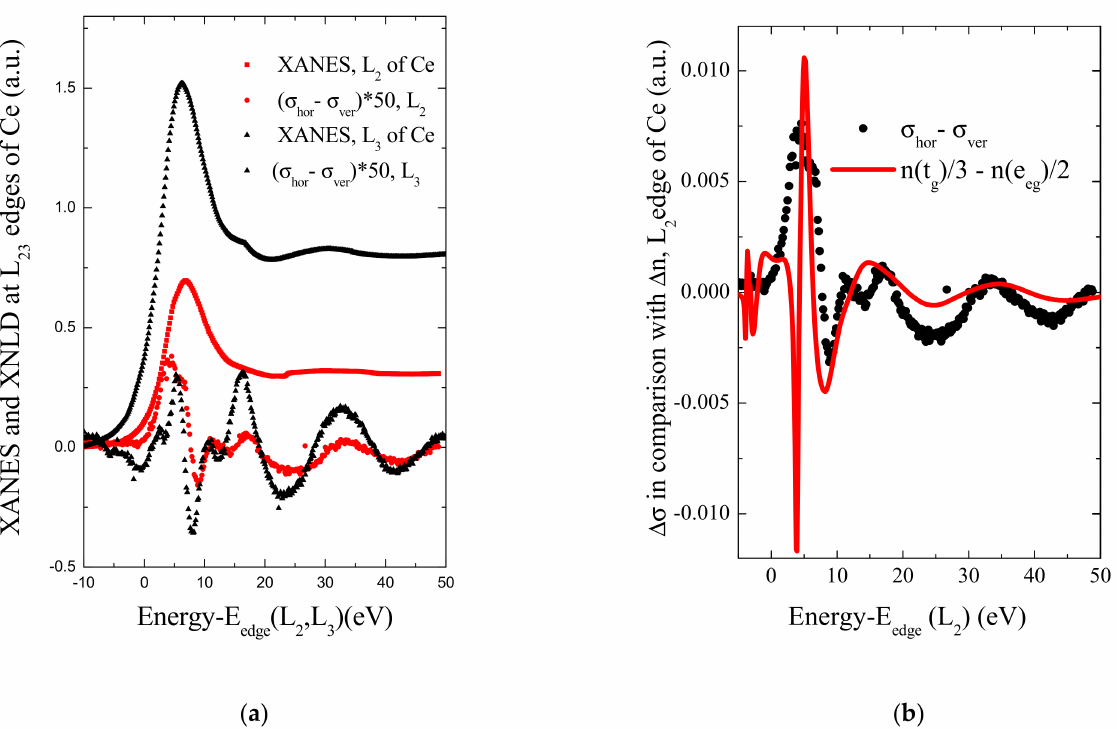
Figure 7. ( a ) Experimental absorption and linear dichroism spectra of L 2 , L 3 Ce edges (reduced to the same energy scale). ( b ) XNLD close to the Ce L 2 -edge in comparison with the difference of the density of the t 2g and e g electronic states in CeCoGe 3 . E edge (L 2 ) = 6164